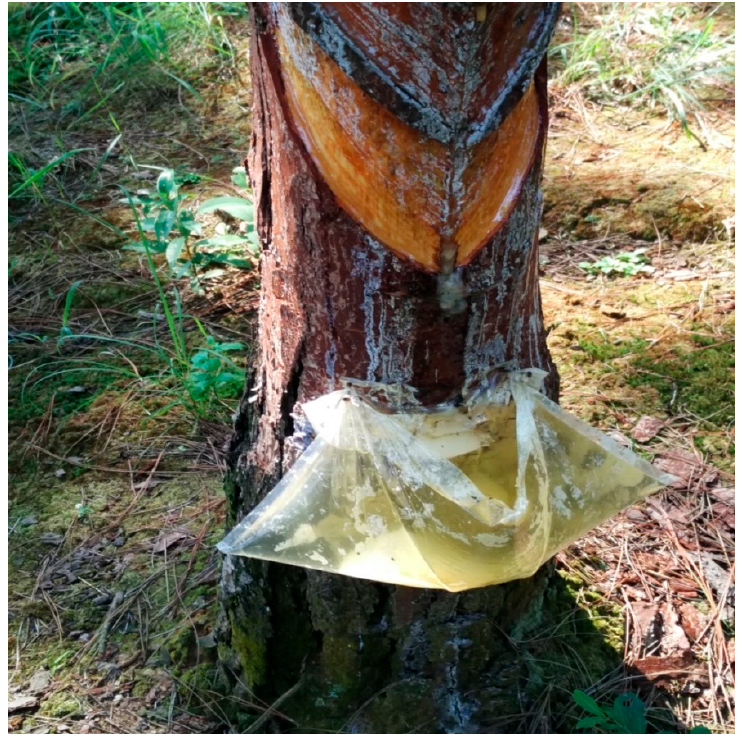
Figure 2. Bark streak wounding method for resin tapping.